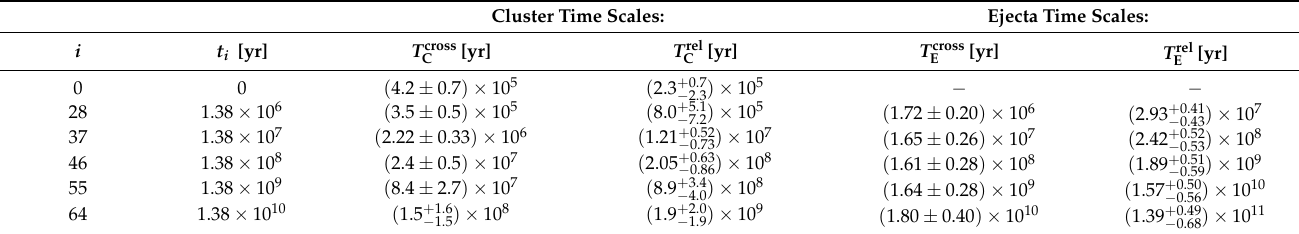
Table 13. Shown are the crossing time, T cross galactic halo at selected times, where P = C,E stands for the cluster and ejecta populations.